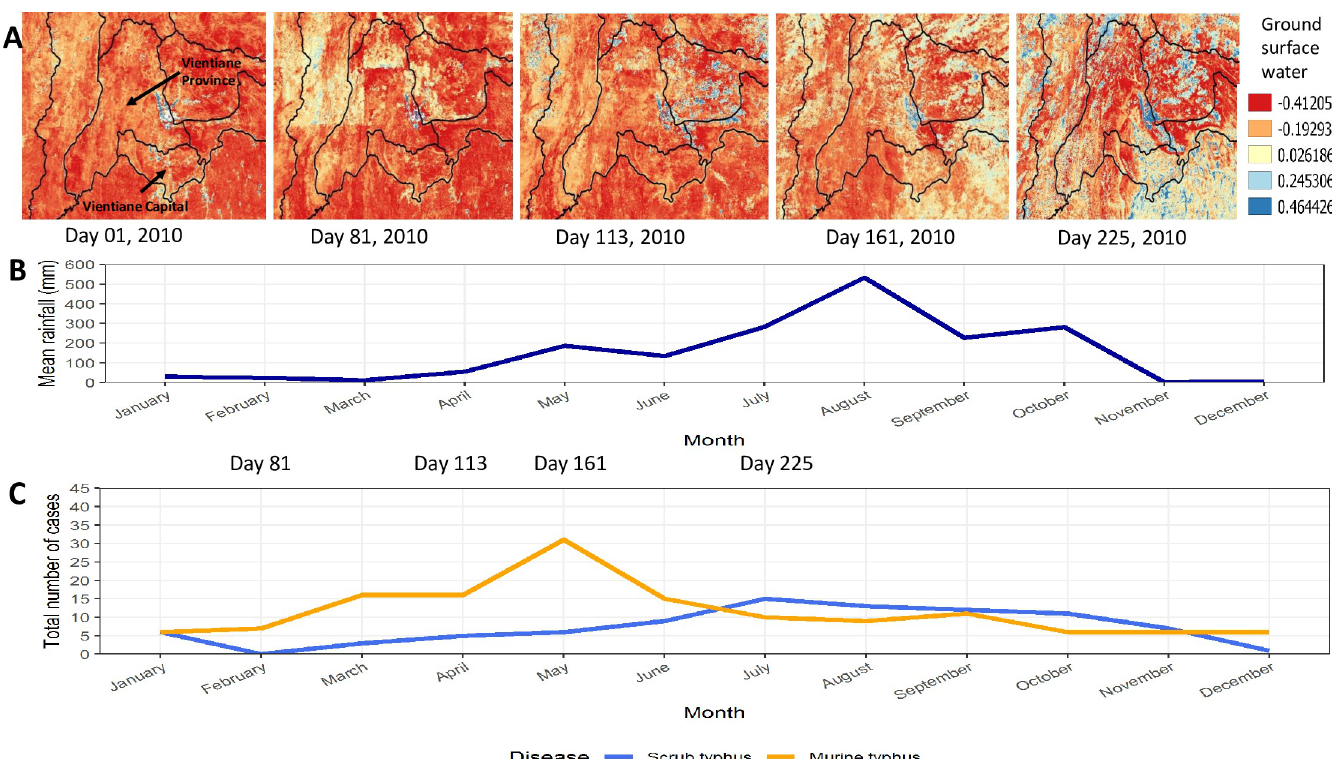
Fig 5. Year 2010. A. Amount of surface water for Vientiane Capital and Vientiane Province B. Combined mean rainfall per month for Vientiane Capital and Vientiane Province C. Number of patients with scrub typhus and murine typhus for Vientiane Capital and Vientiane Province per month. Maps were created using QGIS version 3.4.9. All layers were created by the authors of this